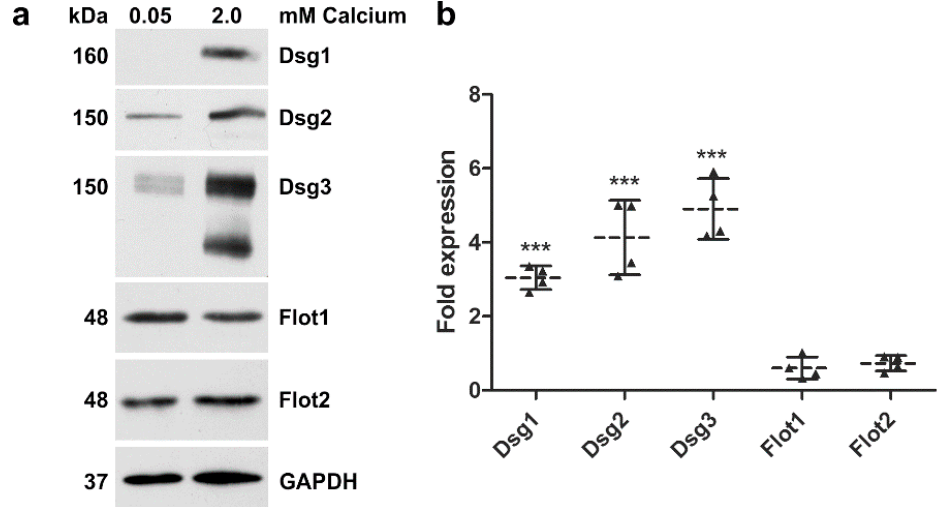
Figure 4. Effect of calcium on the expression of desmogleins and flotillins in hTert cells. The cells were grown in KGM with 0.05 mM calcium, and one plate was treated with 2 mM calcium for 24 h. ( a ) After cell lysis, equal protein amounts of the lysates were loaded onto gel and the expression of the indicated proteins was analyzed by Western blot. Glyceraldehyde 3-phosphate dehydrogenase (GAPDH) was used as a loading control; ( b ) quantification of the bands was performed with Quantity-One software. The expression signal in the 0.05 mM sample was set to one, and the relative fold expression levels in the 2 mM samples are shown as a scatter plot. Statistical analysis was done using one-way analysis of variance (ANOVA) with Bonferroni’s multiple comparison test. Statistically significant di ff erences, as compared to the respective 0.05 mM sample, are indicated by *** p < 0.001. n = 4 independent experiments. Dotted line: Mean of samples, solid lines: